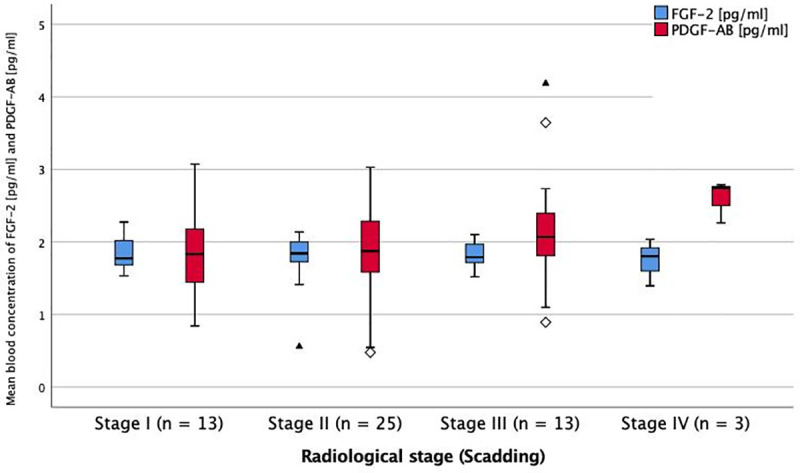
Serum levels of FGF-2 and PDGF-AB in different radiological stages of sarcoidosis at baseline.Mean blood concentration of FGF-2 and PDGF-AB in different radiological stages of sarcoidosis. FGF-2 = fibroblast growth factor-2. PDGF-AB = platelet derived growth factor-AB. * = p < 0.05 (ANOVA + Tukey-test as post-hoc test for multiple comparisons). No significant difference between groups.